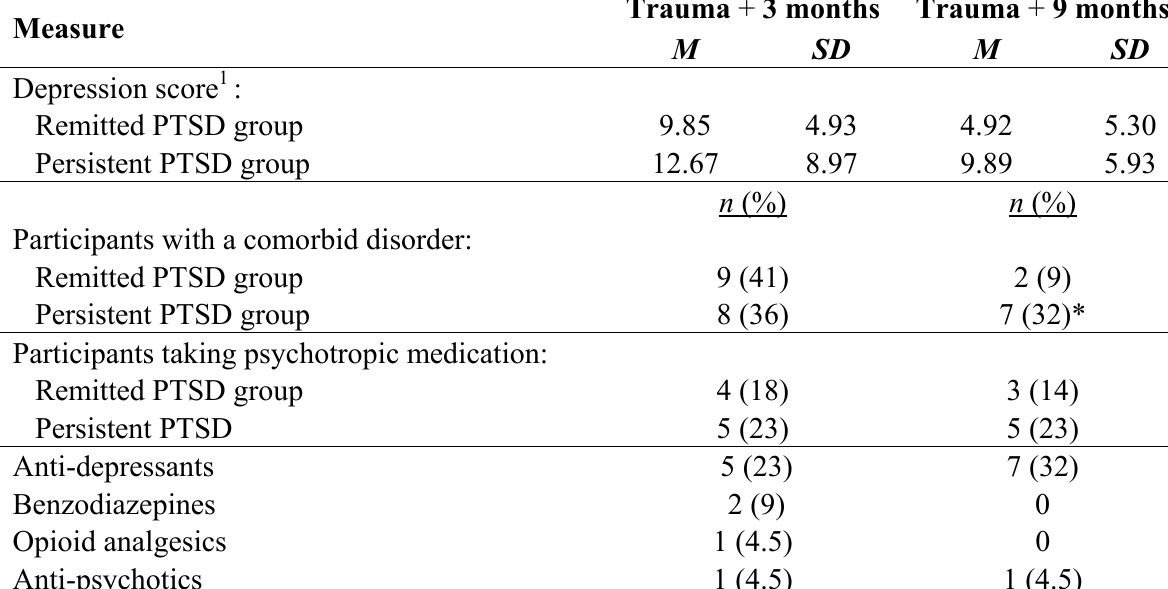
Table 1. Clinical data for the remitted( n = 13) and persistent ( n = 9) PTSD